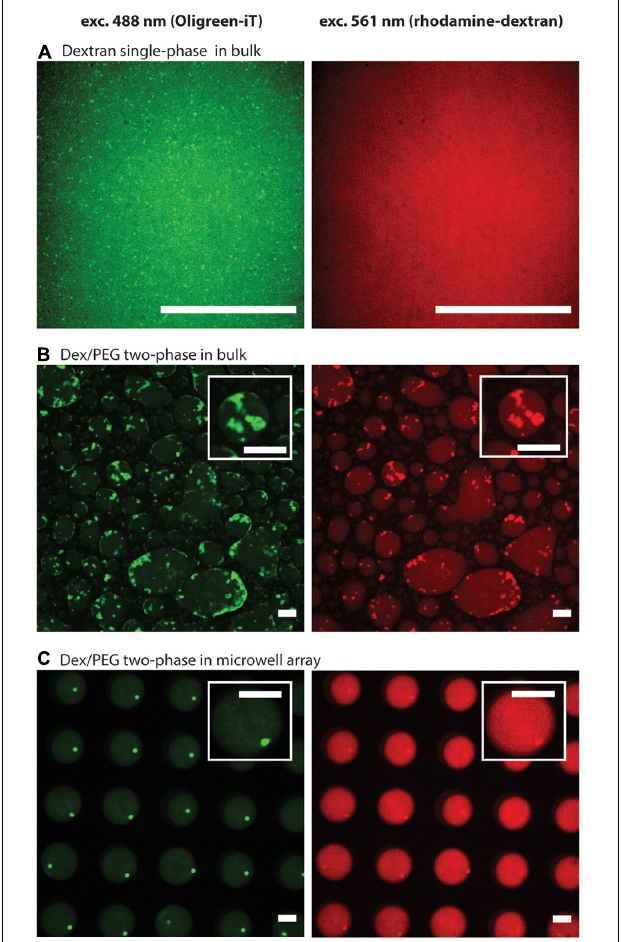
FIGURE 2 | Formation of DNA hydrogel particles in single/two-phase systems and in bulk solutions/microwell arrays after two annealing rounds, displaying the location of the DNA aggregates (left column), and the dextran phase (right column). (A) Dextran single-phase system in a bulk solution: contains 8.33% w/w dextran, 8 µ M per strand of DNA, 1.25 µ M spermine, and 2.5 mM magnesium ions. (B) Dex/PEG two-phase system in a bulk solution: 5 µ L containing 8.33 % w/w dextran, 8 µ M per strand of DNA, mixed with 15 µ L containing 8.33% w/w PEG, 1.66 µ M spermine, and 3.33 mM magnesium ions. (C) Dex/PEG two-phase in a microwell array: array filled 8.33% w/w dextran, 8 µ M per strand of DNA, and washed with a solution containing 8.33% w/w PEG, 1.25 µ M spermine, and 2.5 mM magnesium ions. In all samples the dextran phase contains 10 mM Tris–HCl, 0.01% w/w rhodamine-dextran, 2/10000-diluted Oligreen. The PEG phase contains 10 mM Tris–HCl. About the conditions, see also Supplementary Table 2 . Scale bars = 50 µ